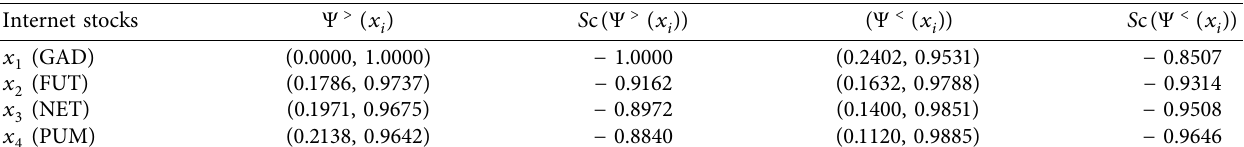
Table 4: Te PF-SIR fows.